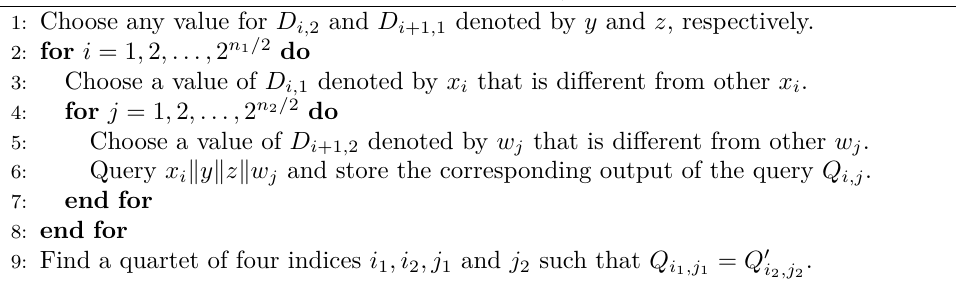
Algorithm 2 Attack Procedure for Case 2 with L 1 , 1 =